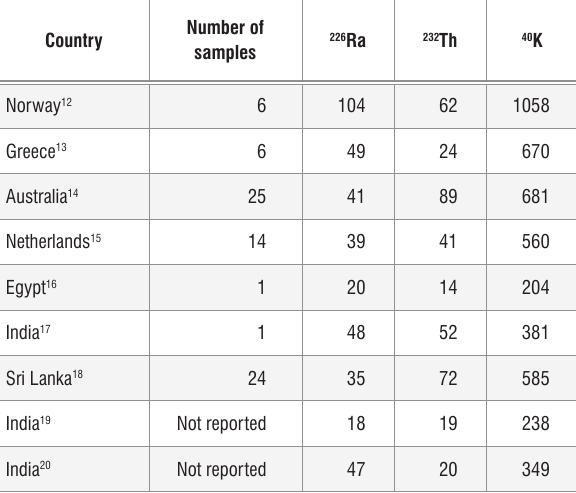
Activity concentrations (Bq/kg) of 40 K, 232 Th and 226 Ra in building